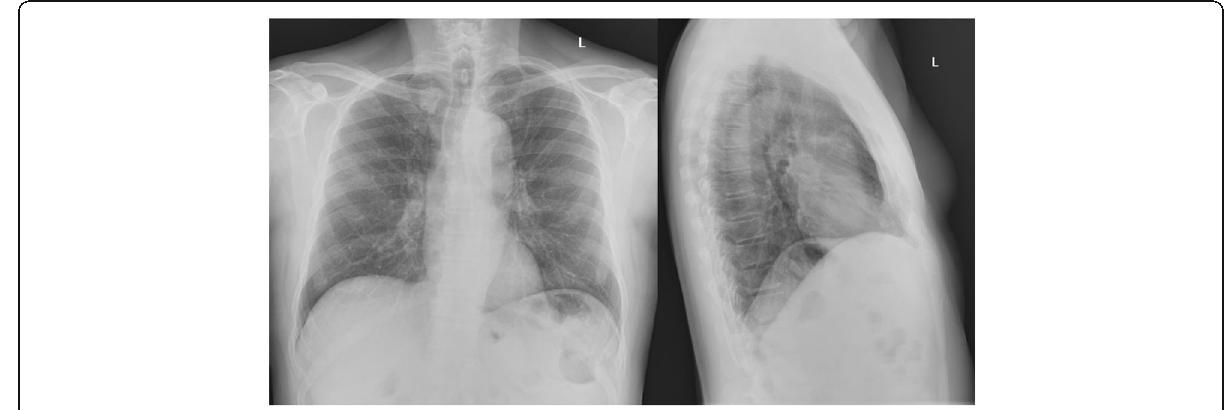
Fig. 3 Chest-RX, PA, and LL projections (March 13). No evidence of pleuro-parenchymal alterations in both lung